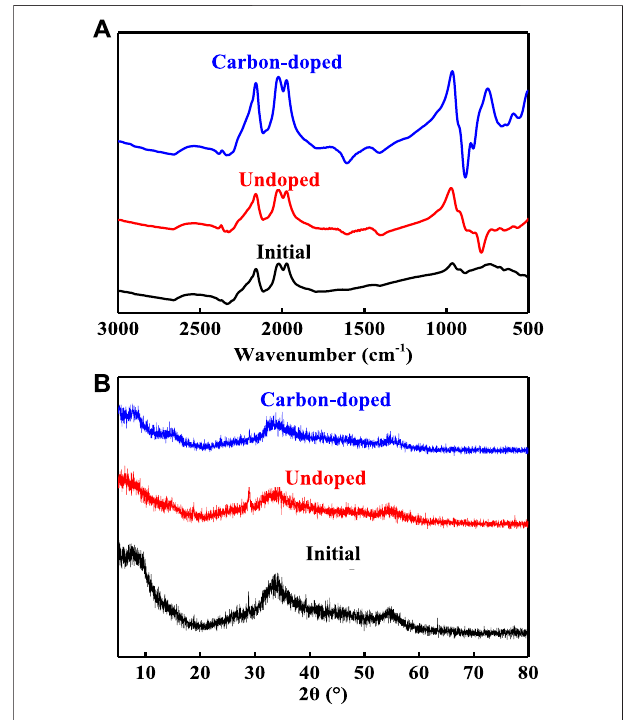
FIGURE 3 | (A) FT-IR spectra and (B) XRD patterns of the initial, undoped, and carbon-doped MoSe 2